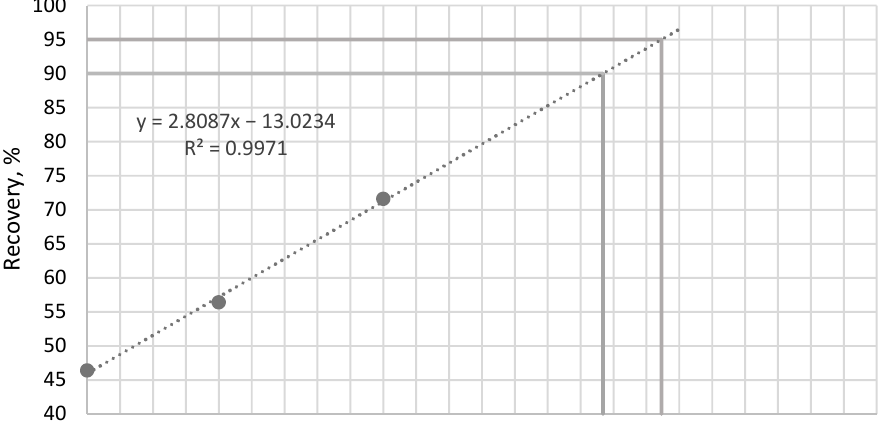
Figure 2. Results of linear extrapolation to determine the MMP.